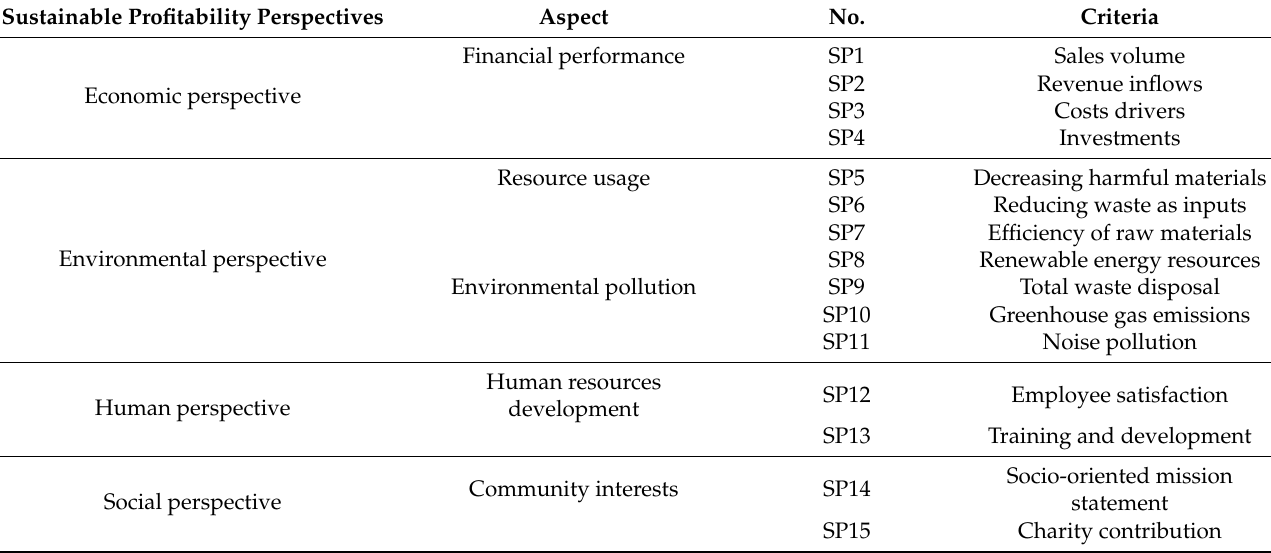
Table 1. Sustainable profitability